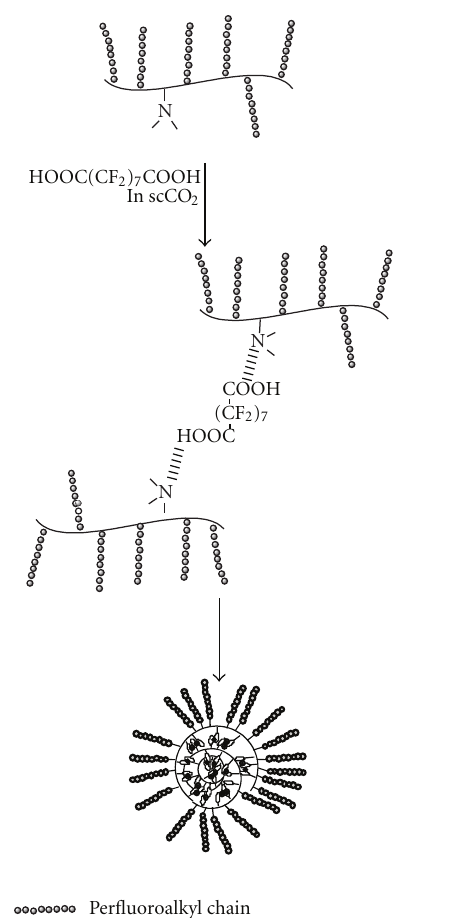
Scheme 6: A schematic of the formation of the nanospheres.